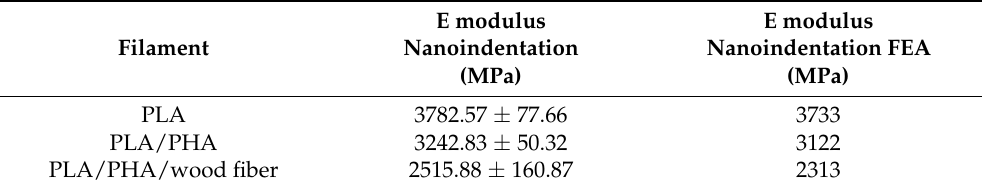
Table 4. Comparison of the elastic moduli of nanoindentation of the PLA, PLA/PHA and PLA/PHA/wood fiber